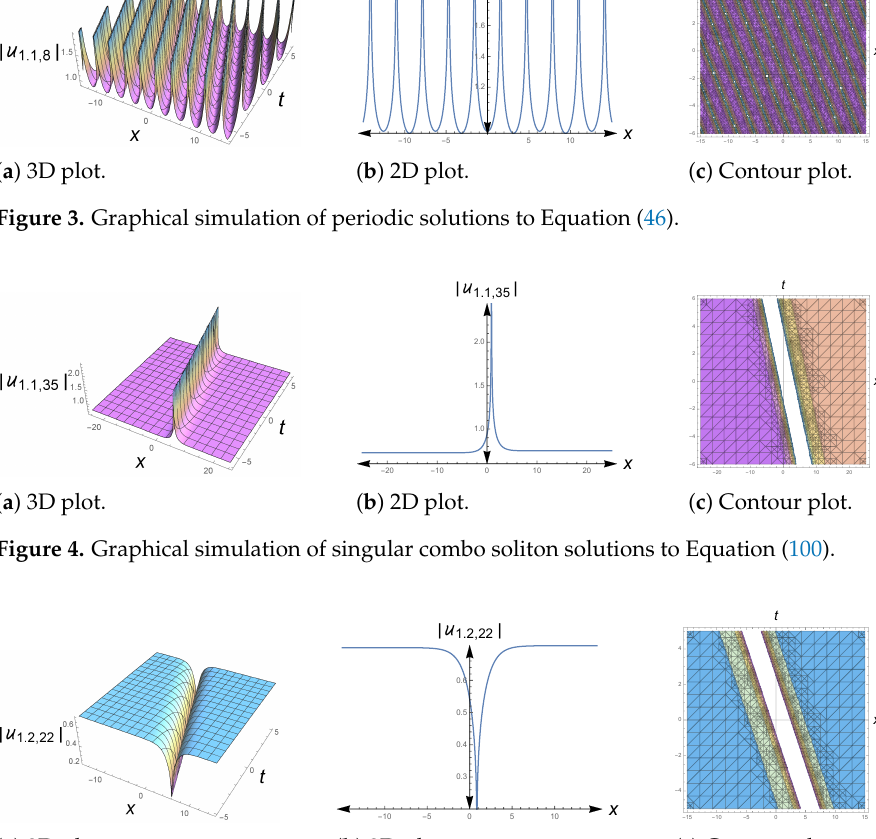
( a ) 3D plot. ( b ) 2D plot. ( c ) Contour plot. Figure 5. Graphical simulation of hyperbolic solutions to Equation